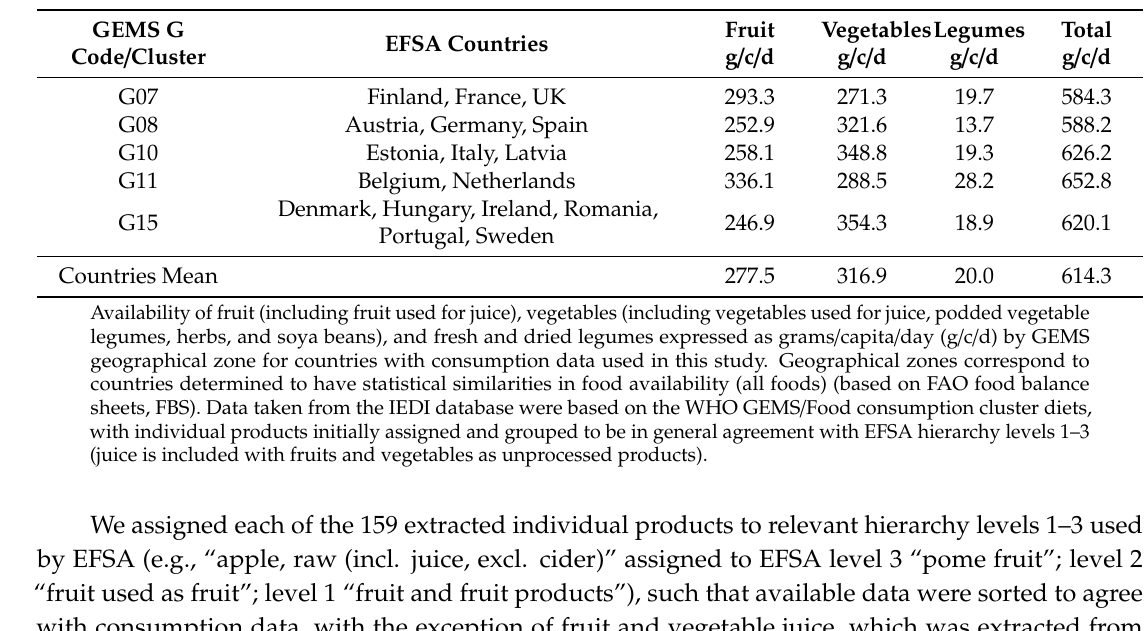
Table 1. Food type availability divided by class and geographical